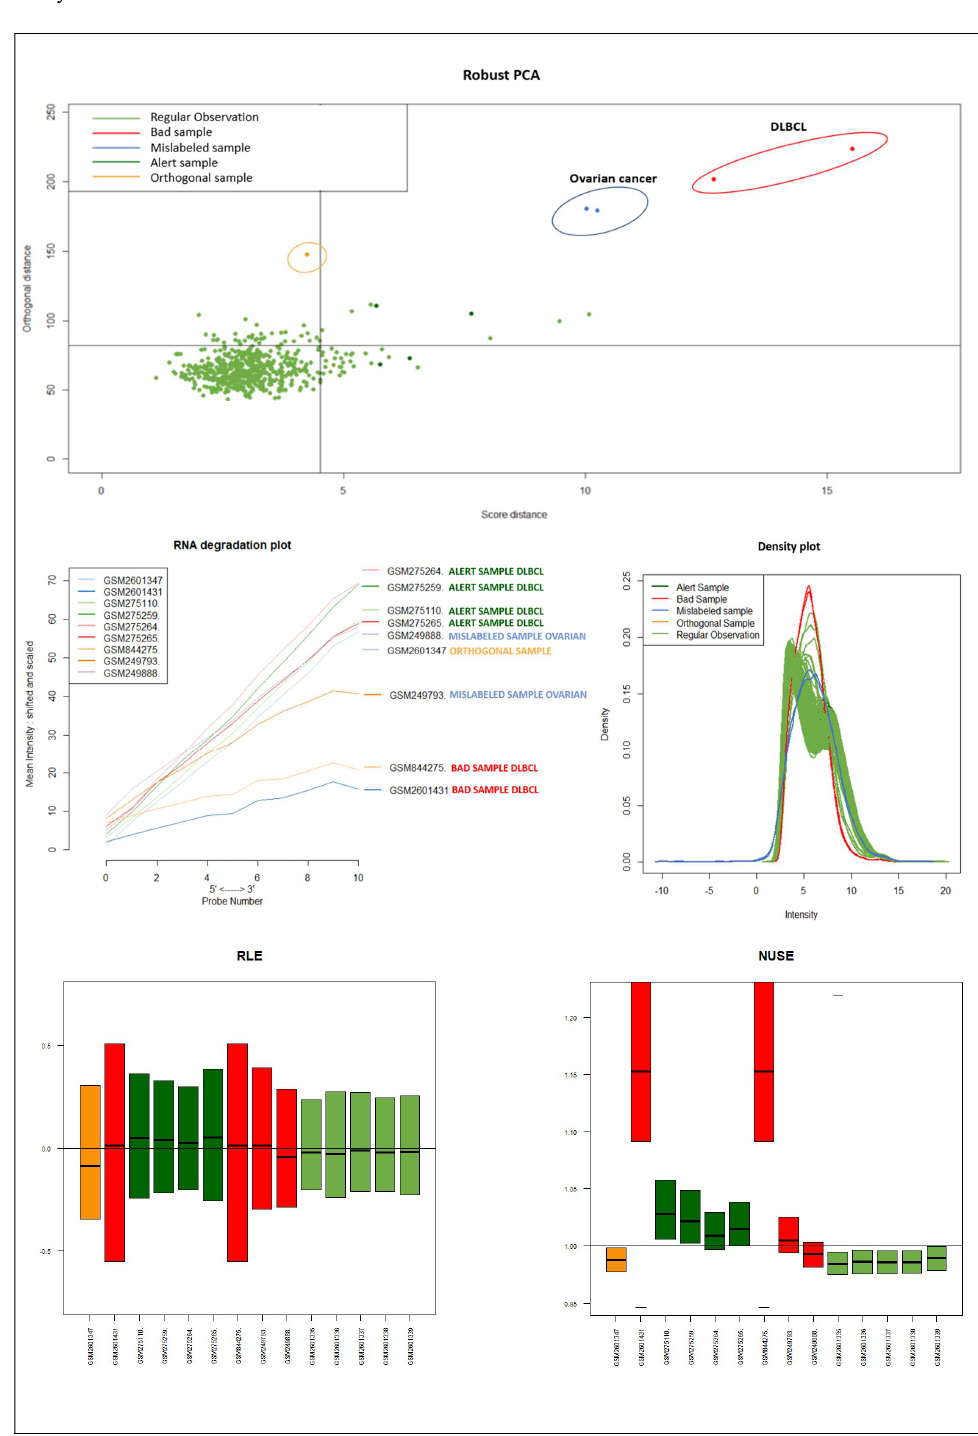
Figure A1. Summary of quality array measures for Dataset